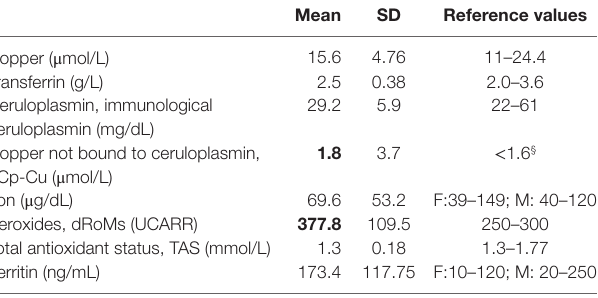
Table 2 | Values of the biological variables in the stroke acute phase